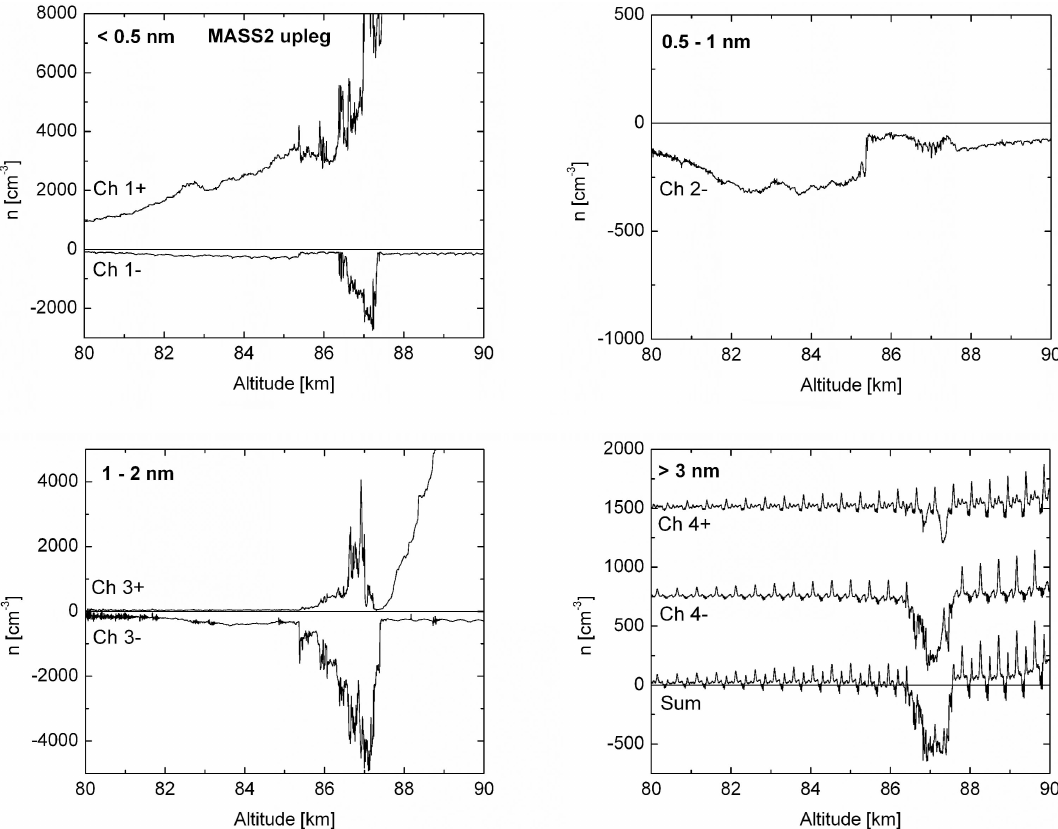
Fig. 8. Data from 7 of the 8 channels of the MASS instrument for the upleg of the second flight. Channels 4+ and 4 − are offset from zero and their sum is plotted correctly. Channels 4 appear noisy because the vertical scale spans a smaller range than in Figs. 6 and